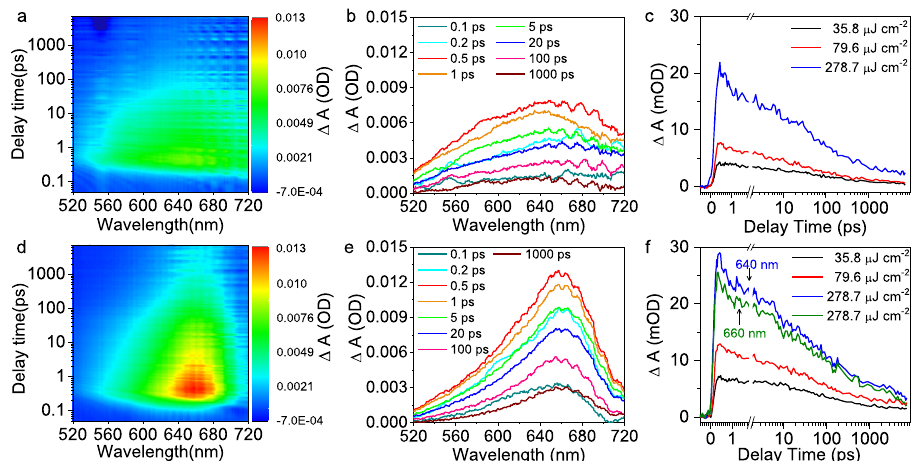
Fig. 5 Femtosecond transient absorption spectra (fs-TAS) of PCN-NaCA-2. a , b fs-TAS upto 7 ns delay times after excitation by 365 nm laser pulse with energy density of 79.6 μ J cm − 2 in glycerol aqueous solution (3.5 wt%) under vacuum. c fs-TAS decay kinetics pro fi les monitored at the wavelength of 640 nm under vacuum with a series of excitation energy densities. d , e fs-TAS upto 7 ns delay times after excitation by 365 nm laser pulse with energy density of 79.6 μ J cm − 2 in glycerol aqueous solution (3.5 wt%) in 1 atm. O 2 atmosphere. f fs-TAS decay kinetics pro fi les monitored at the wavelength of 640 and